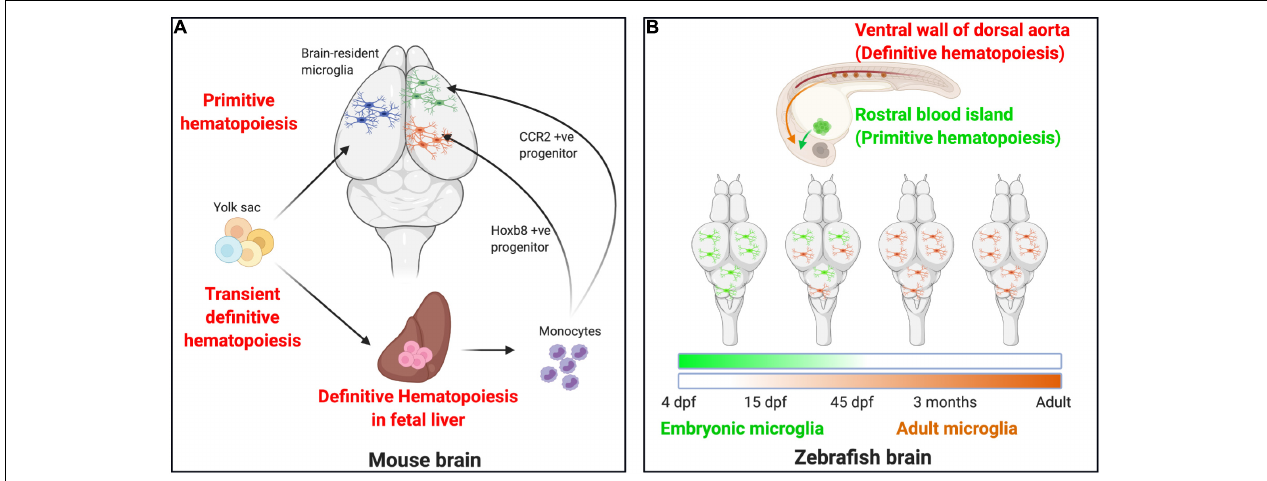
FIGURE 1 | Microglial ontogeny models. (A) Mouse: Primitive hematopoiesis in the embryonic yolk sac blood islands at E7.5–E8.0 results in the formation of not just erythrocytes but also highly proliferative macrophage progenitor cells that migrate to the brain. The primitive macrophages colonizing the early developing brain at E8.5 proliferate and give rise to the brain-resident microglia population. A second wave, the transient definitive hematopoiesis in the yolk sac, gives rise to erythromyeloid progenitor cells by E8.0–E8.5 and to T- and B-lymphoid progenitor cells by E9.0. On reaching the fetal liver by E10.5, these cells undergo definitive hematopoiesis to result in the formation of all hematopoietic lineage cells, including monocytes. Recent studies now indicate that definitive hematopoiesis also partly contribute to the brain resident microglia population through hoxb8 + and CCR2 + monocyte populations taking up residence in the early developing brain parenchyma by E12.5 and E17.0, respectively. (B) Zebrafish: Embryonic microglia originating in the rostral blood islands through primitive hematopoiesis by 4 dpf migrates to and populates the embryonic brain until 15 dpf, they disappear entirely by 45 dpf. In essence, the embryonic microglia are replaced by another wave of incoming microglia that arise as a result of definitive hematopoiesis occurring in the ventral walls of the dorsal aorta beginning at 15 dpf. They are the dominant microglia population by 45 dpf and serve as adult microglia throughout the fish’s life.